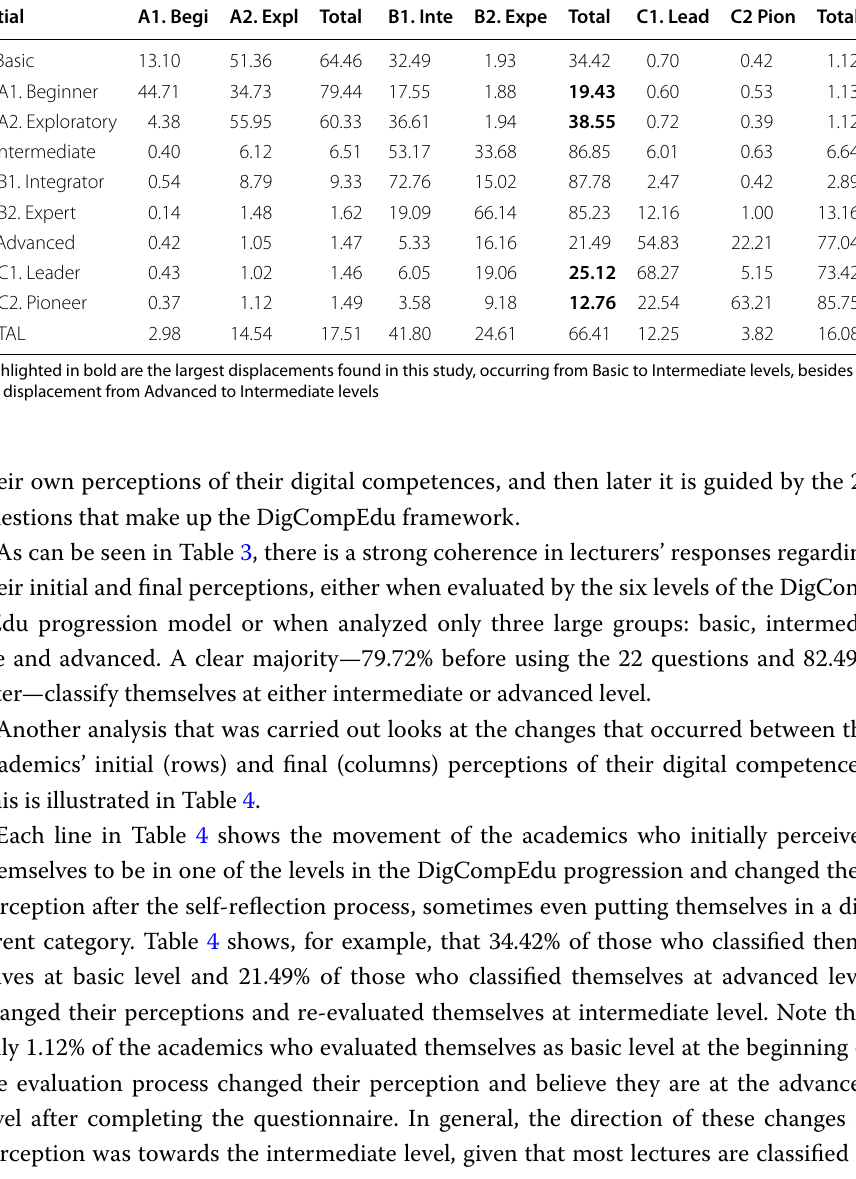
Table 4 Changes in digital competences according to the initial (rows) and final (columns) perception (all values are in %)